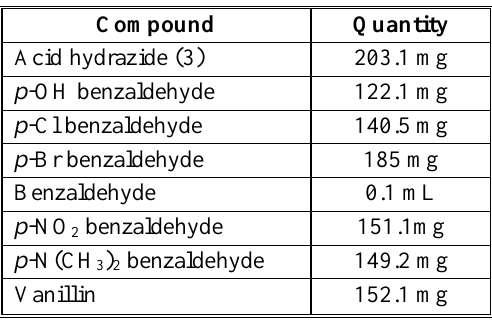
Table 1. Quantity of reactants that equal to 1